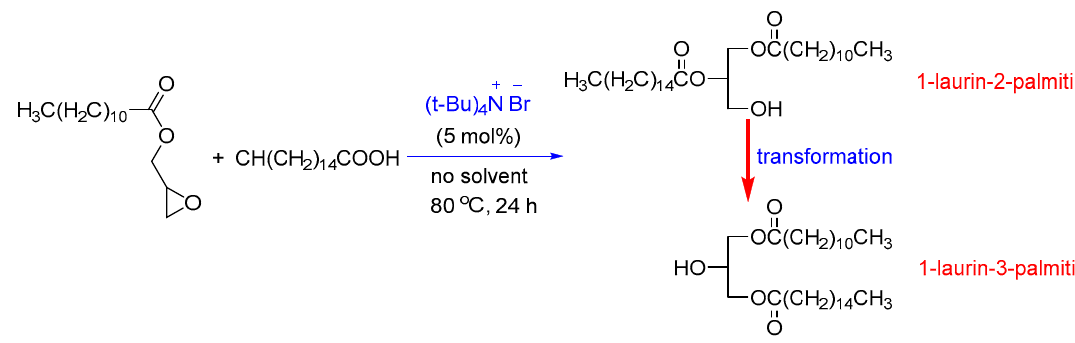
Figure 1. Synthesis route of 1-laurin-3-palmitin (1,3-LP).